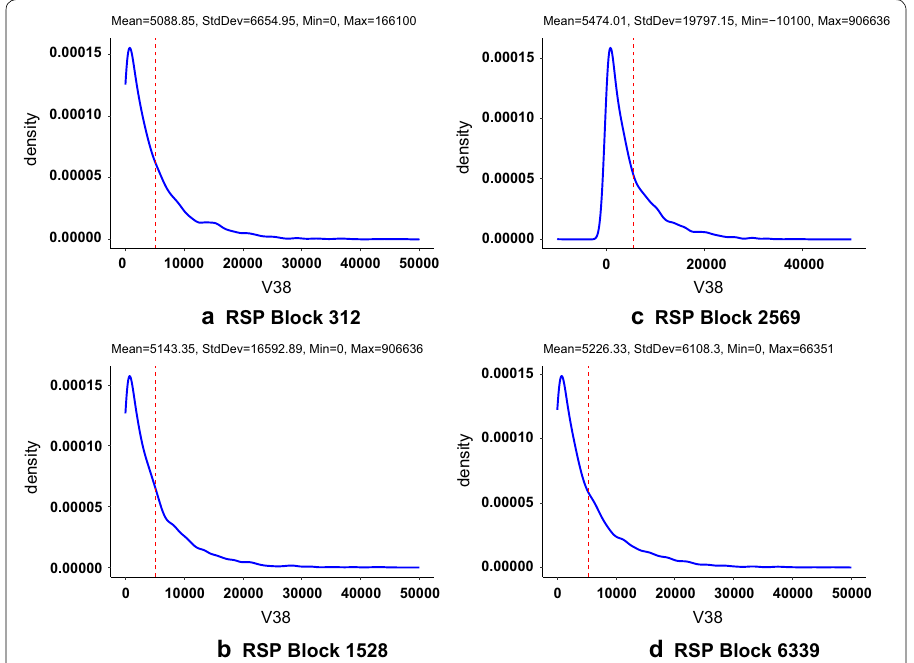
Fig. 7 Exploring the data distribution in Power data. Density plots of V38 in 4 RSP blocks from Power